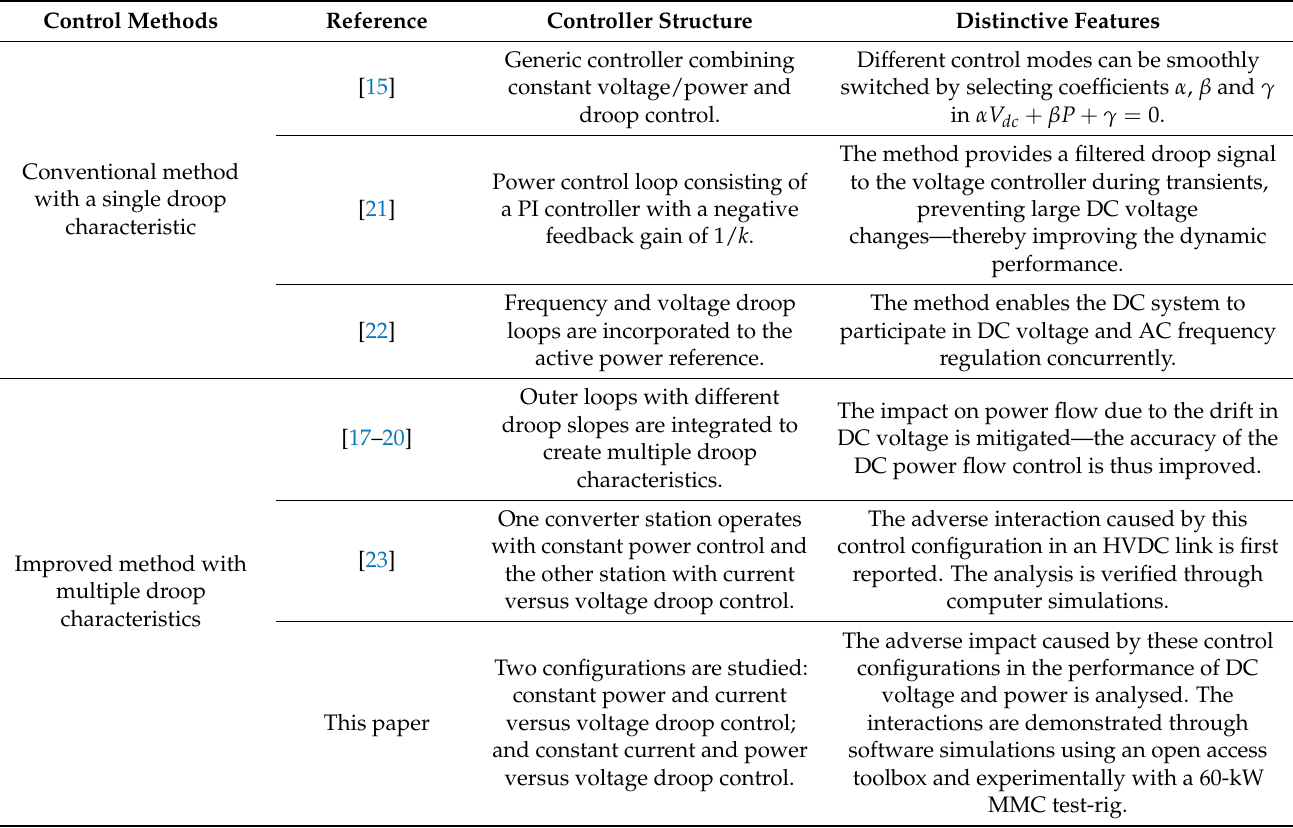
Table 1. Comparison between HVDC control